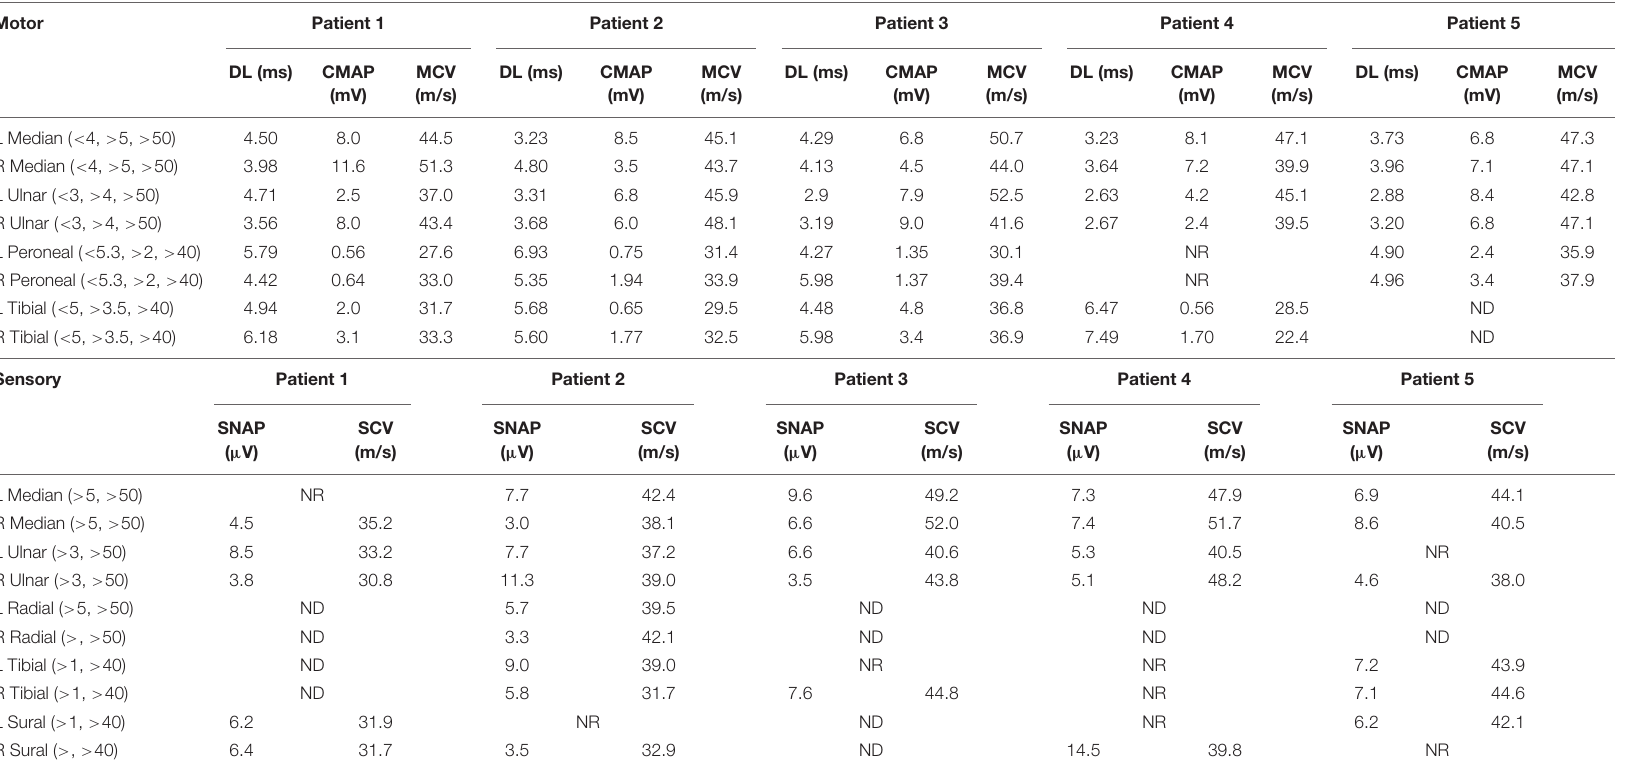
TABLE 2 | Electrophysiological study of patients with abnormal GGC repeat expansions.